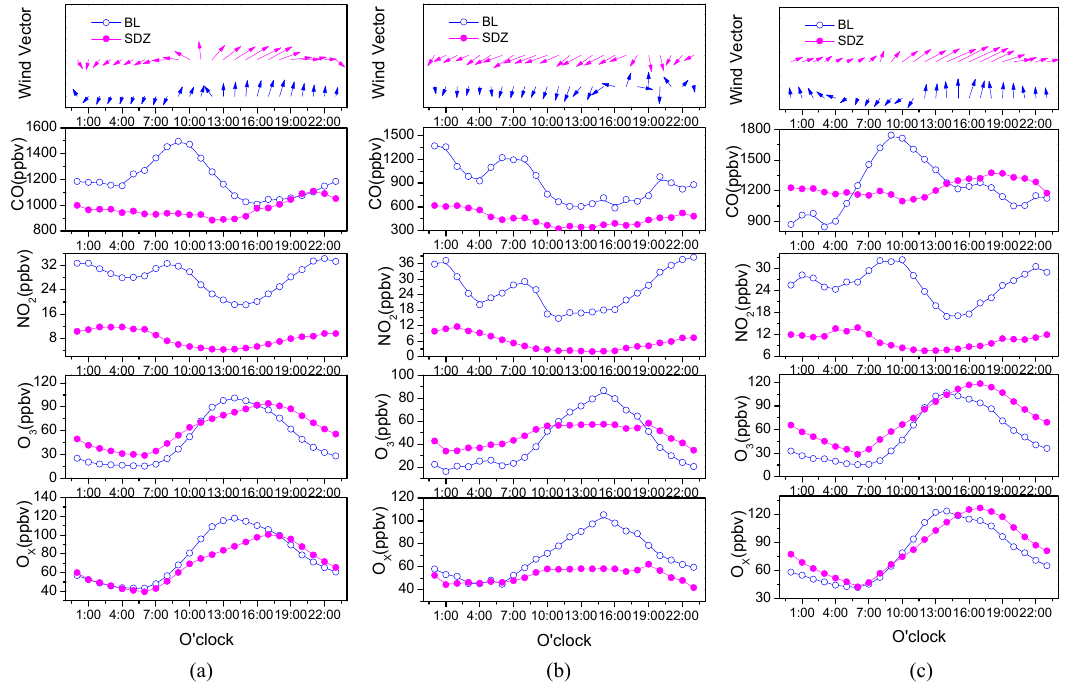
Fig. 9. Diurnal variation of wind vectors and CO, NO 2 , O 3 , and O x concentrations at the BL and SDZ sites for the three groups: (a) Type A, (b) Type B, and (c) Type C. Fig.9. Diurnal variation of wind vectors and CO, NO and SDZ sites for the three groups: (a) Type A, (b) Type B, and (c) Type C. 3